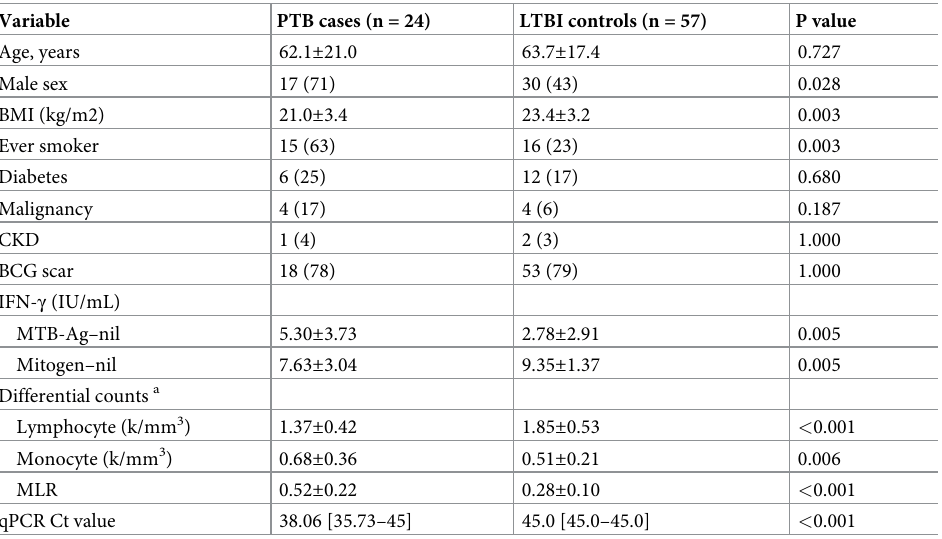
Table 1. Characteristics of patients with PTB and controls with LTBI ( n =